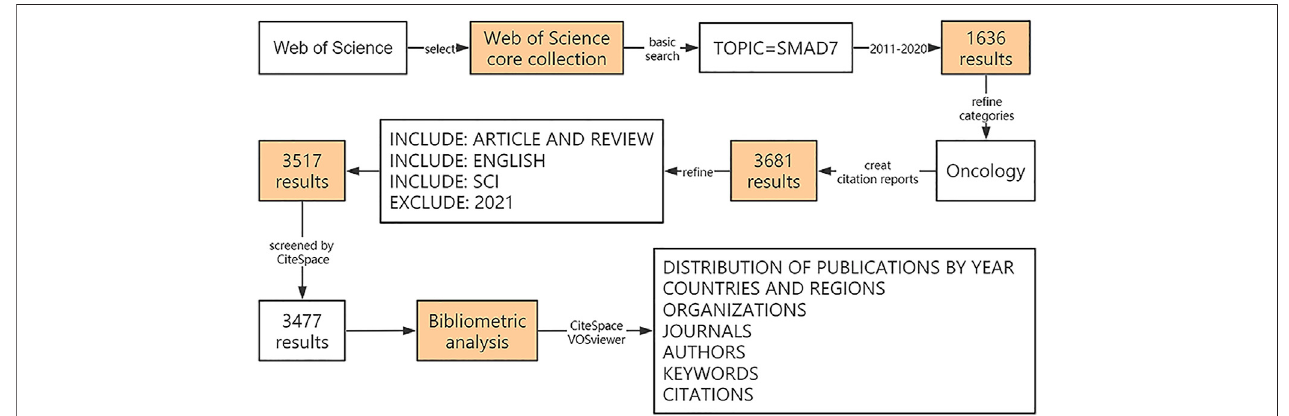
FIGURE 1 | Detailed fl owchart steps of the search strategy in the screening of